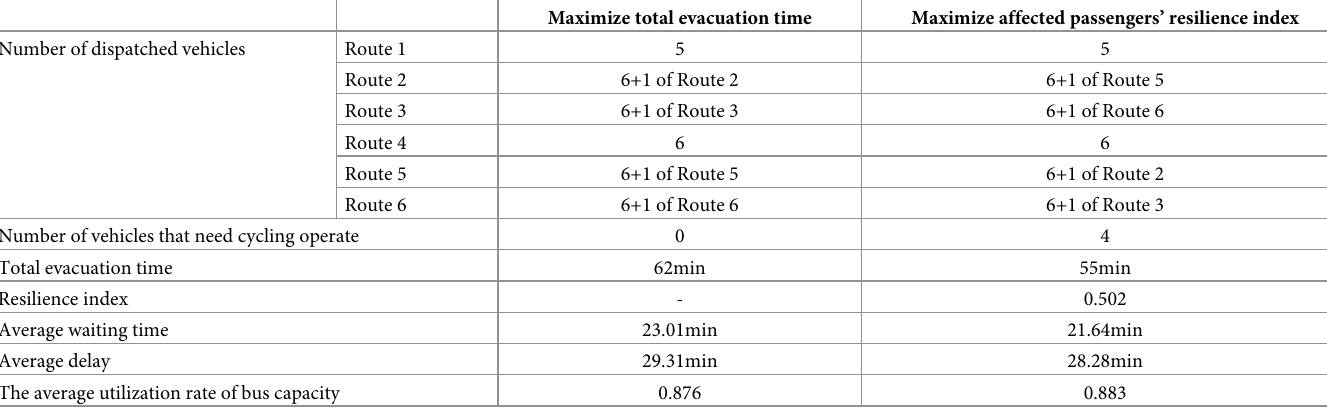
Table 7. The comparison of different optimization